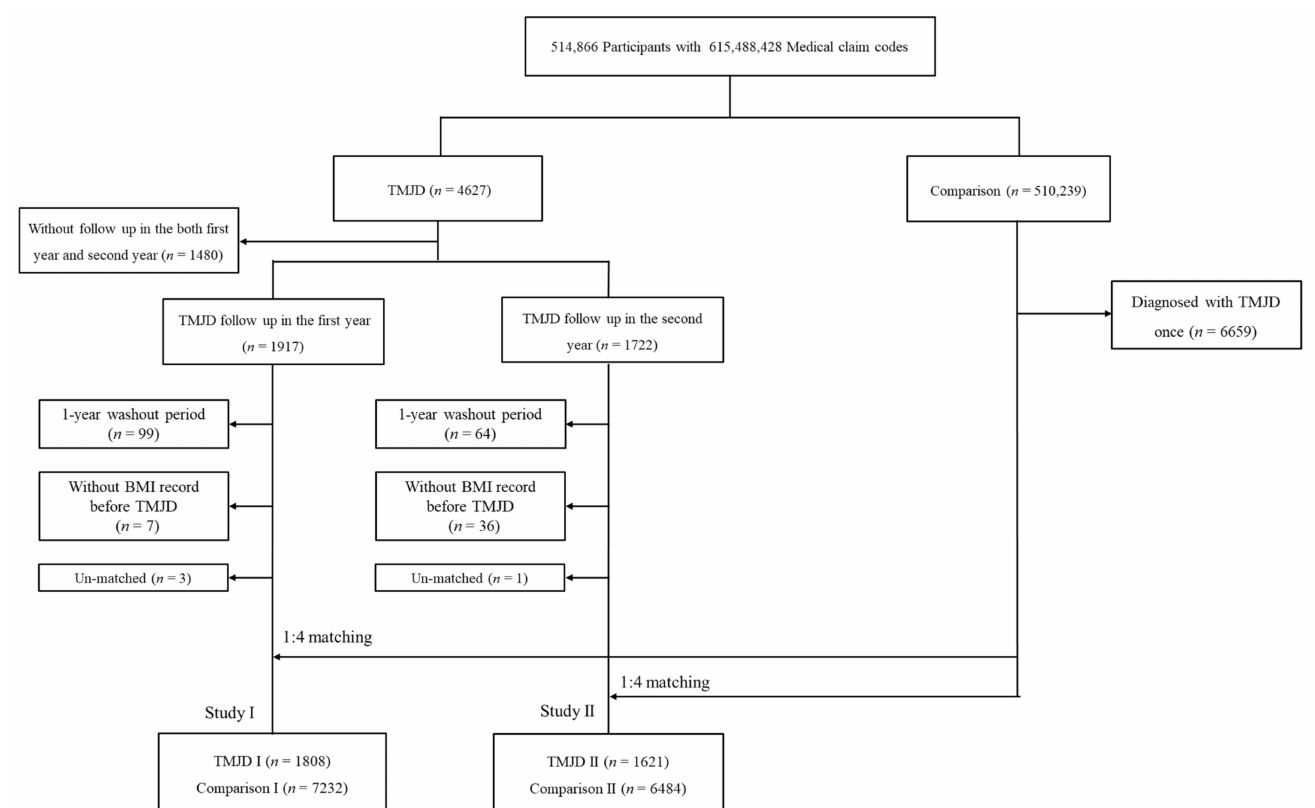
Figure 1. A schematic illustration of the participant selection process that was used in the present study. Of a total of 514,866 participants, 4627 TMJD participants were selected. Among them, we excluded participants without histories of first- or second-year follow-up records ( n = 1480). Then, participants were categorized as TMJD I with a first year of follow-up ( n = 1917) and TMJD II with a second year of follow-up (1722). A total of 492 TMJD participants were included in both groups. After the exclusion of 1 year of wash out, participants without BMI records, and unmatched participants, TMJD participants were 1:4 matched with comparison